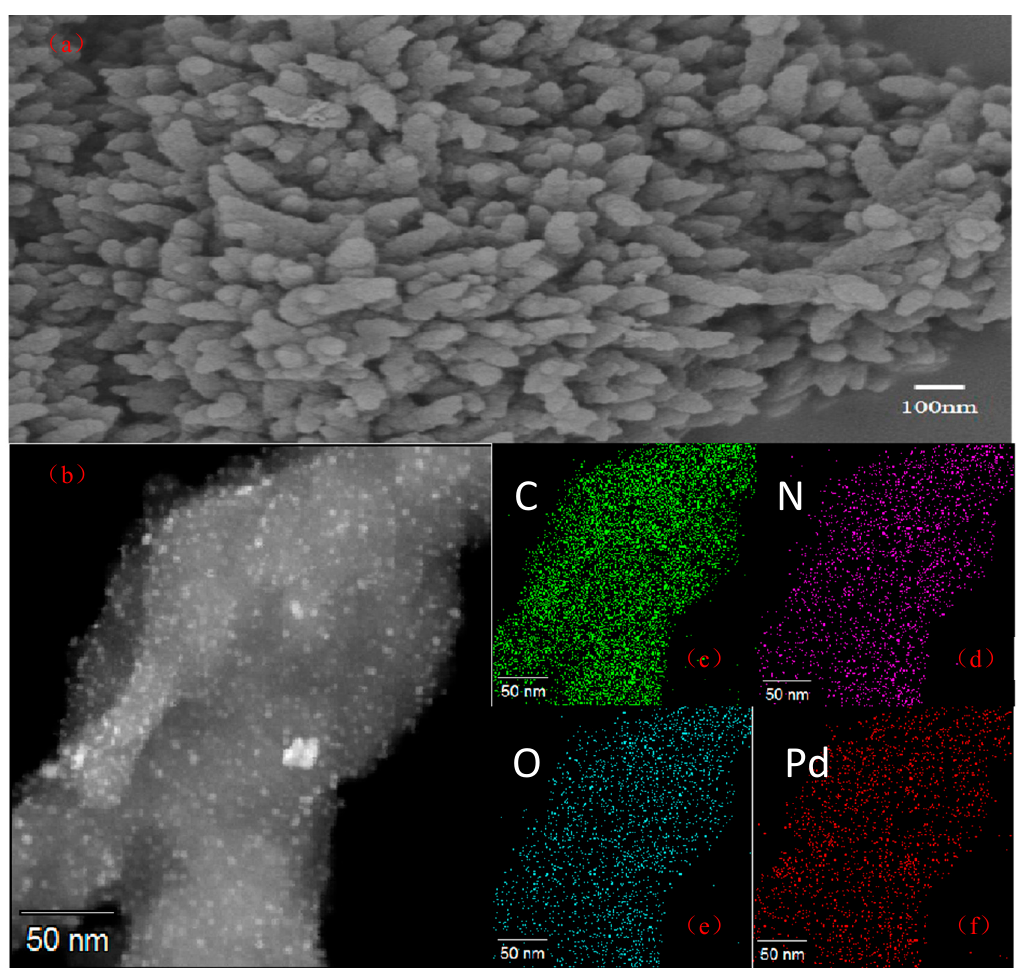
Figure 2. SEM image ( a ) and EDS mapping ( b–f ) of reduced COF-supported Pd-SJ04.